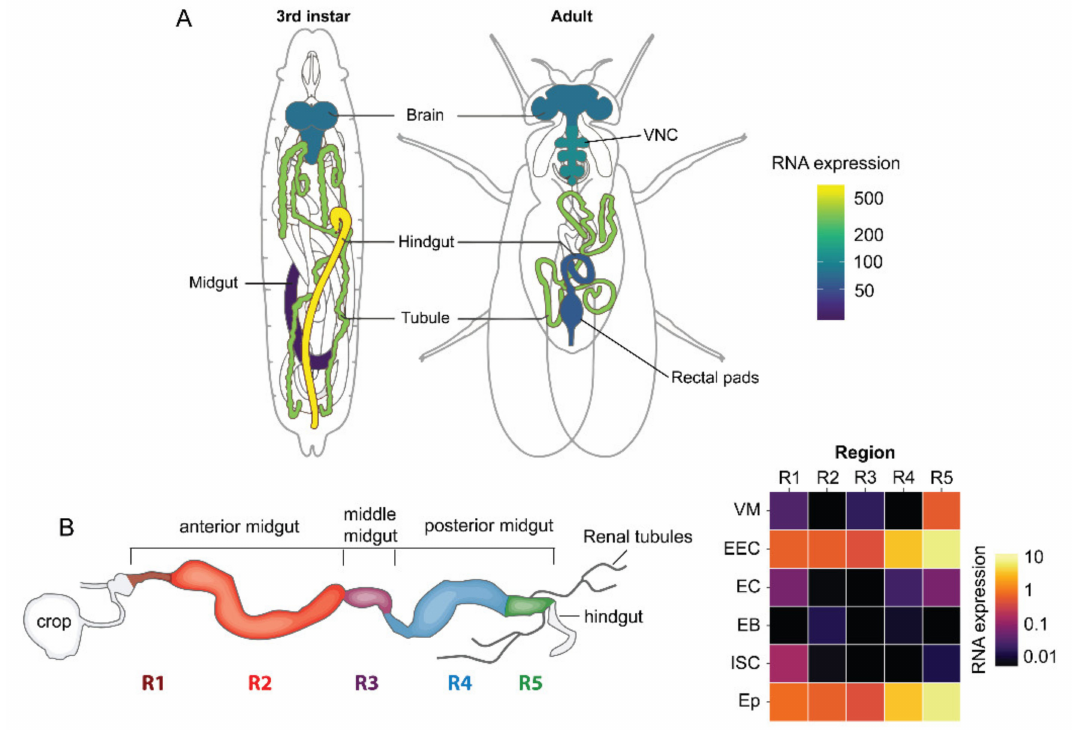
Figure 6. Expression of the leucokinin receptor ( Lkr ) in tissues of Drosophila . ( A ) Schematics of third instar larvae and adult fly showing the expression of Lkr (Data from FlyAtlas.org, [112]). ( B ) A schematic of the adult intestine and heat map showing expression of Lkr in different regions of the gut (R1 to R5) and its various cell types (VM, visceral muscle; EEC, enteroendocrine cell; EC, enterocyte; EB, enteroblast; ISC, intestinal stem cell; Ep, epithelium). Data were mined using Flygut-seq [113]. This figure was reproduced from [38] with permission from the